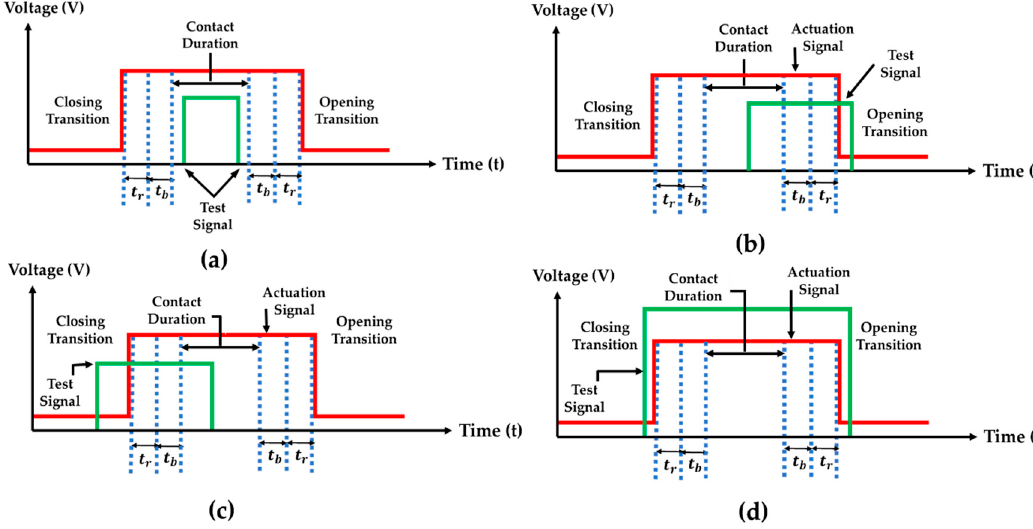
Figure 7. Illustrations of relative timing with respect to test signal: ( a ) Cold-switching, ( b ) hot closure, ( c ) hot opening, and ( d ) hot-switching.